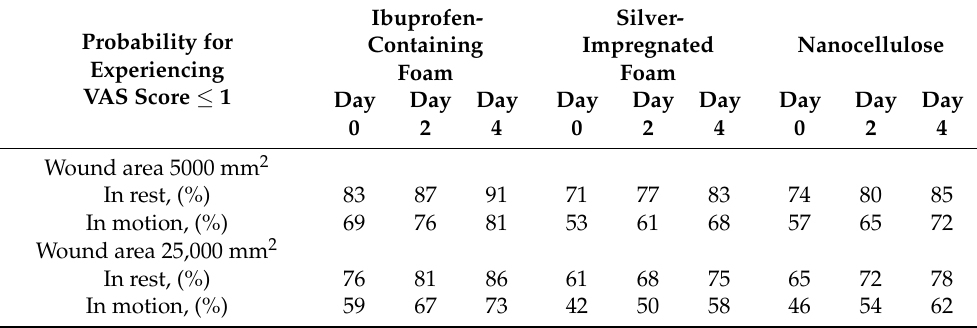
Figure 2. Probability for experiencing almost no pain (VAS score ≤ 1) at rest (thin lines) or in motion (thick lines) with ibuprofen-containing foam (b, green), silver-impregnated foam (c, blue) and bacterial nanocellulose (d, red). Small wounds (wound area 5000 mm 2 ; solid line) had a higher probability of experiencing less pain compared to larger wounds (wound area 25,000 mm 2 ; dotted line). Pr, probability; VAS, visual analogue score. Table 2. The probability for experiencing almost no pain (VAS score ≤ 1) at rest or in motion in a wound area of 5000 mm 2 or 25,000 mm 2 . VAS, Visual Analogue Scale.